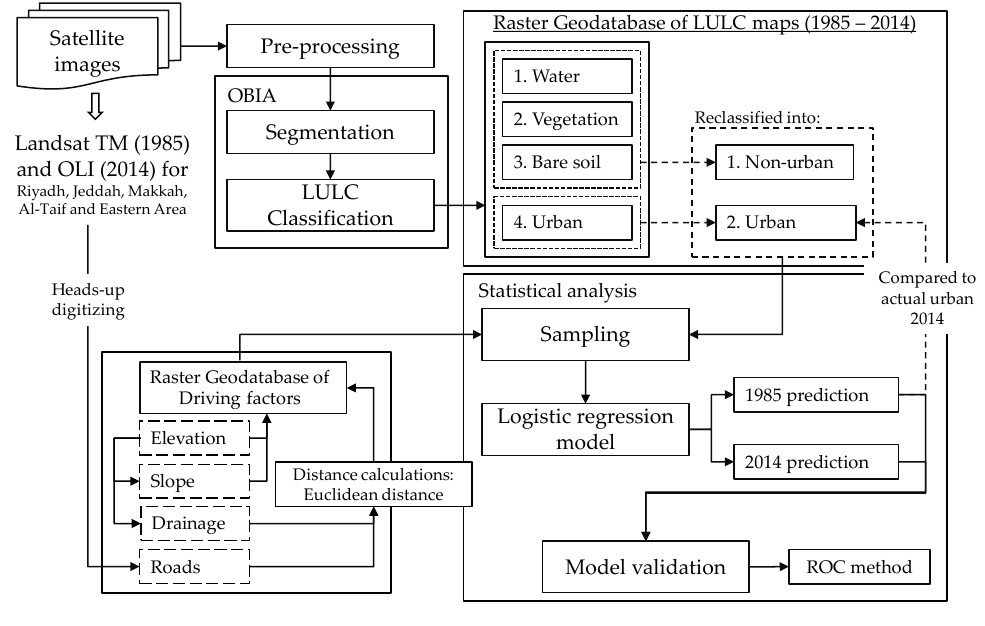
Figure 4. Flowchart of the research methodology. Table 2. Estimated results of the logistic regression model in Riyadh of the four independent